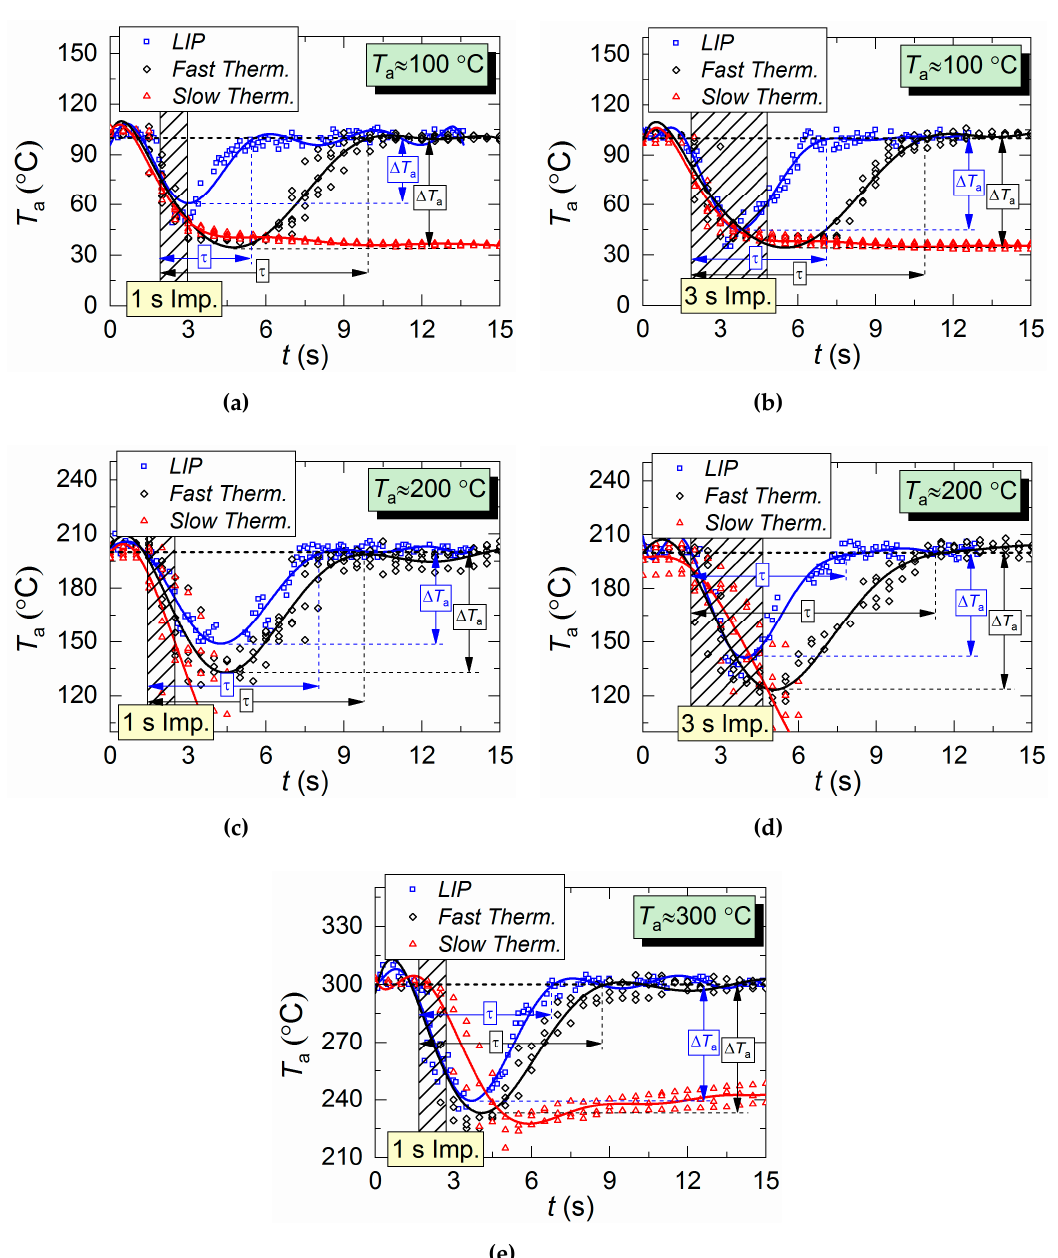
Figure 5. Air temperature variation in the trace of droplet flow during a single (1–3 s) injection of droplets: ( a,b ) T a ≈ 100 °C; ( c,d ) T a ≈ 200 °C; ( e ) T a ≈ 300 °C.